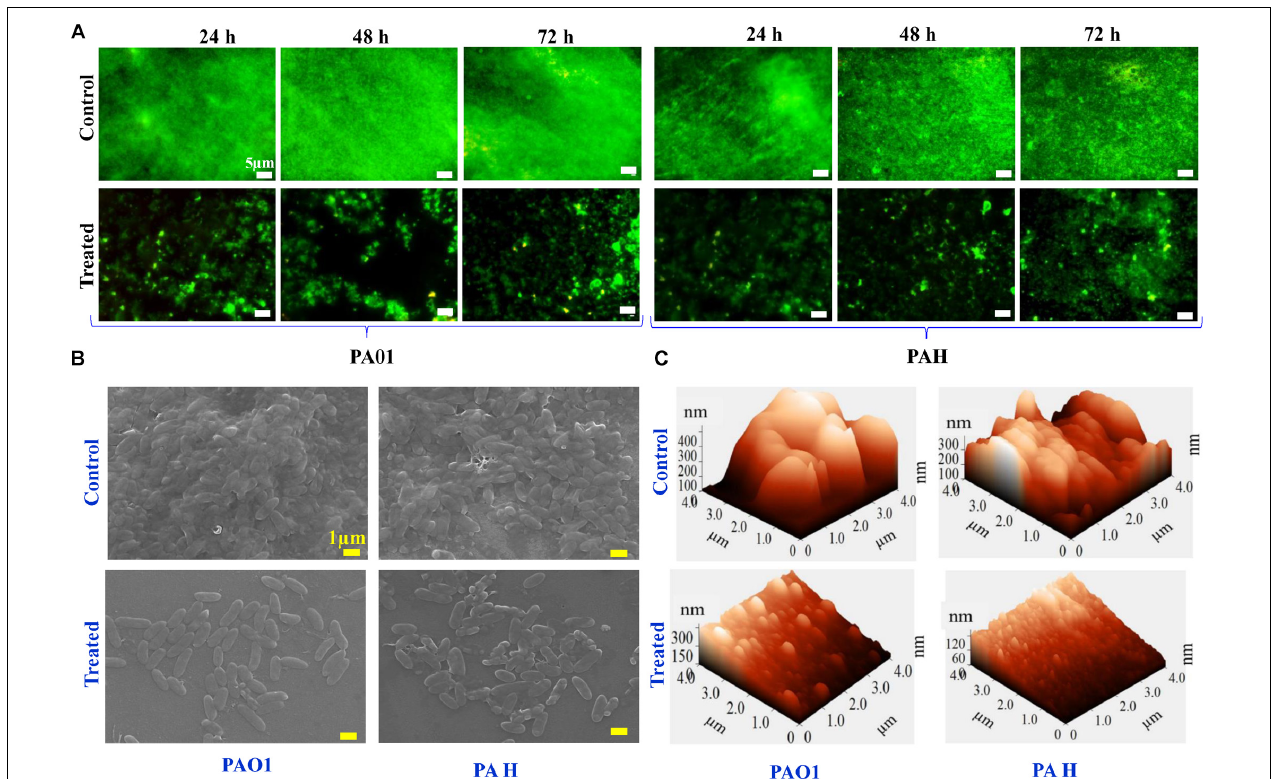
FIGURE 4 | Effect of E. indicum SJ16 extract on cell viability, and topology of biofilms developed by P. aeruginosa . (A) The effect of the bacterial extract (1.0 mg/ml) on the viability of reference P. aeruginosa strains (PAO1 and PAH) in the biofilm was examined under an epifluorescence microscope at different time points (24, 48 and 72 h) and compared with control. The dead bacterial cells were labeled with propidium iodide whereas live cells were stained with SYTO 9, which produced red and green fluorescence, respectively. SEM (B) and AFM (C) images illustrate the effect of the bacterial extract (1.0 mg/ml) on biofilm formation and topology. (B) A well-grown biofilm along with adhering bacterial cells was observed in the control samples (normal biofilm developed by P. aeruginosa ), whereas dispersed bacterial cells were observed in treated samples under SEM. Similarly, AFM (C) showed a disrupted surface topology and a height distribution profile of the biofilm developed by the reference P. aeruginosa strains in the presence of the bacterial extract compared to the control